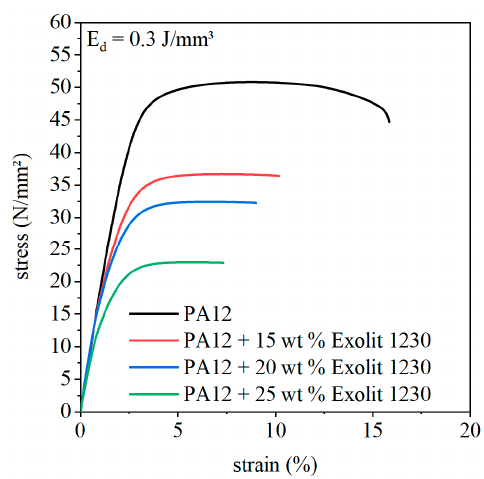
Figure 12. Averaged stress–strain curves of laser-sintered specimens for different flame retardant concentrations and an energy density of 0.3 J/mm³.